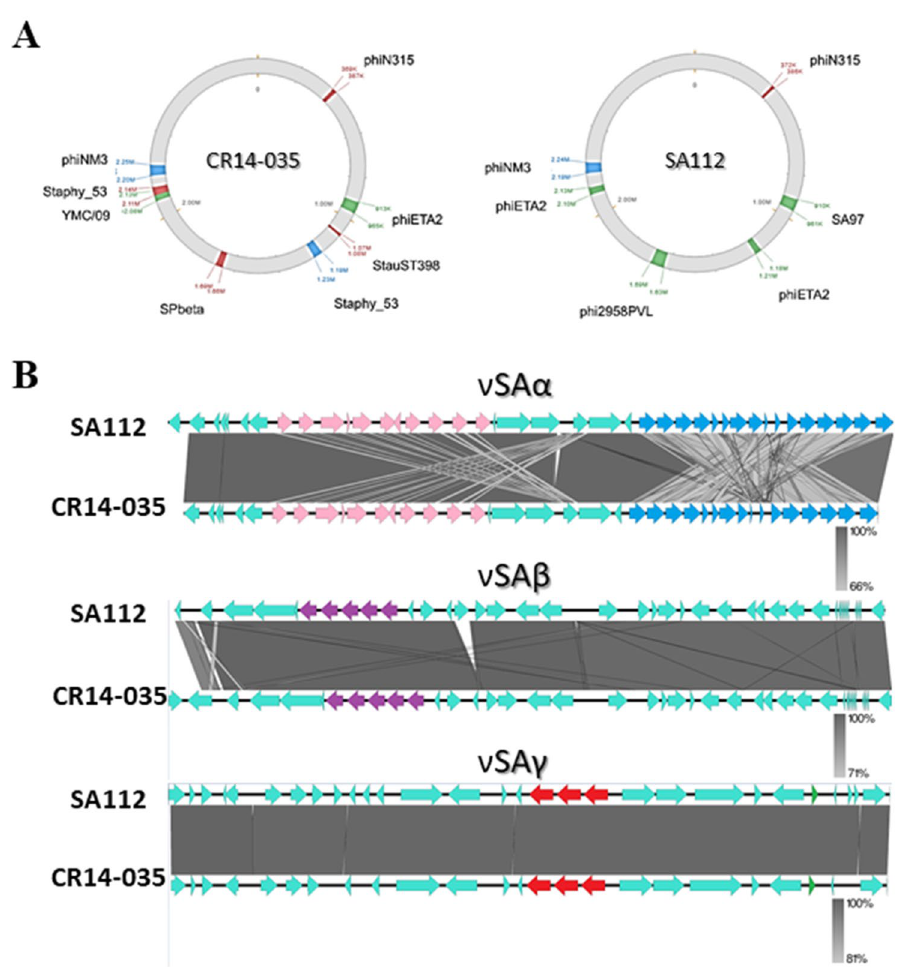
Figure 4. Regions of genomic plasticity corresponding to bacteriophages and important genomic islands. ( A ) Schematic representation of the position of bacteriophages in the ST5 genomes of the MRSA strains SA112 (from canine) and CR14-035 (from human) sequenced in this study. ( B ) Alignment of the genomic island carrying important virulence genes in the genome of the strains SA112 (from canine) and CR14-035 (from human). In νSAα the set genes are highlighted in pink and lpl genes are highlighted in blue. The splABCDF operon in νSAβ is highlighted in purple. In νSAγ, set genes are highlighted in red and psmβ is highlighted in green.